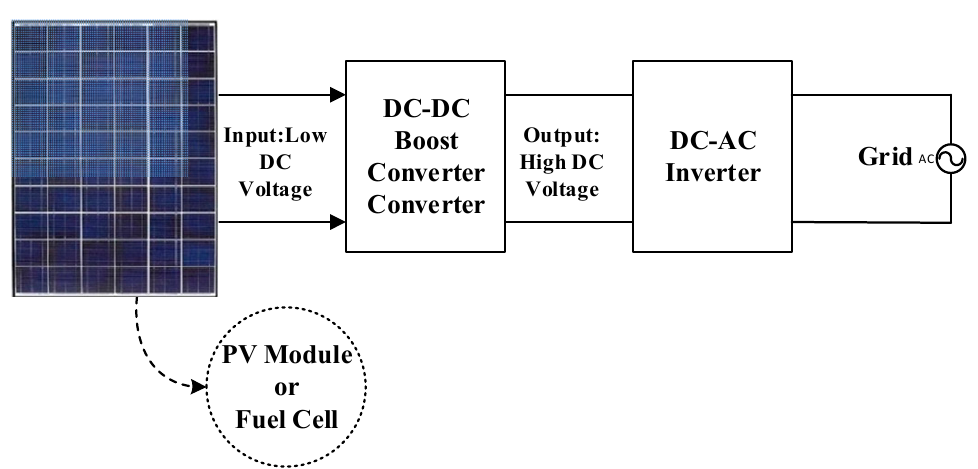
Figure 1. The block diagram of the two-stage power conversion system.